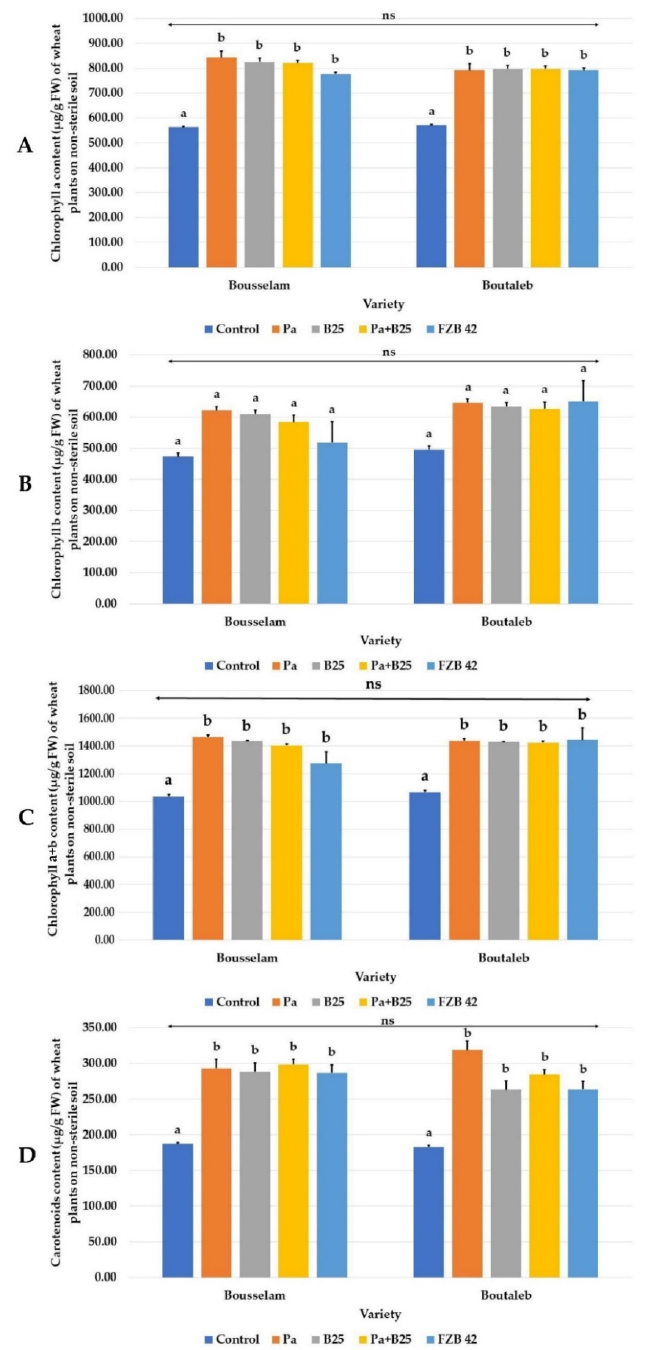
Figure 10. Effect of bacterial inoculation on ( A ) chlorophyll a ( µ g/g FW), ( B ) chlorophyll b ( µ g/g FW), ( C ) chlorophyll a + b ( µ g/g FW), and ( D ) carotenoid ( µ g/g FW) contents of wheat plants grown on non-sterile soil of Bousselam and Boutaleb varieties. The bar plots represent the mean ± standard error of three different experiments. IBM SPSS Statistics v.24 was used to perform statistical analysis, using a two-way ANOVA and Tukey’s multiple comparison post-test. ns: non-significant.